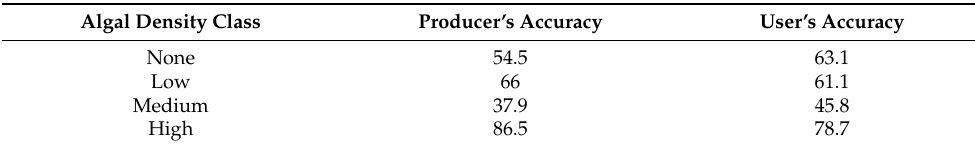
Table 3. Producer’s and user’s accuracies for each algal density class for the September 15 WorldView3 image of the Maumee reach of the Buffalo River example featured in Figure